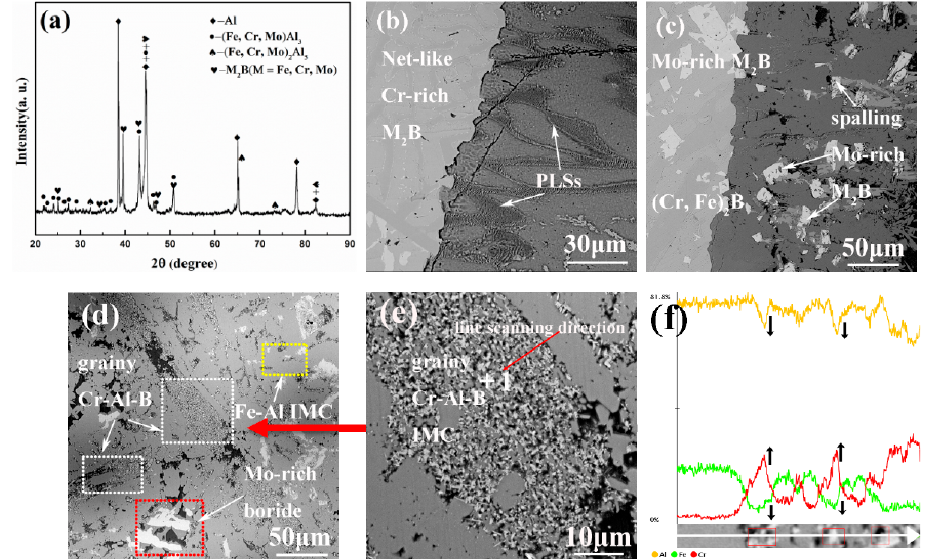
Figure 9. The characterization of the corrosion products layer: ( a ) the XRD pattern of the cross-sectional corrosion layer; ( b , c ) BSE images of cross-sectional interfacial layer; ( d ) the longitudinal interfacial layer; ( e ) magnification view of the grainy Cr-Al-B IMCs; ( f ) EDX line analysis in ( e ).